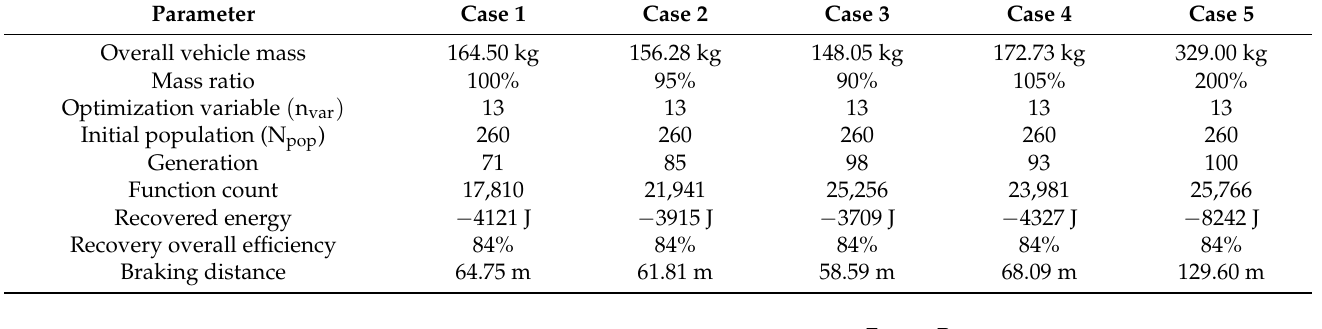
Table 3. Optimization results for mass variation.